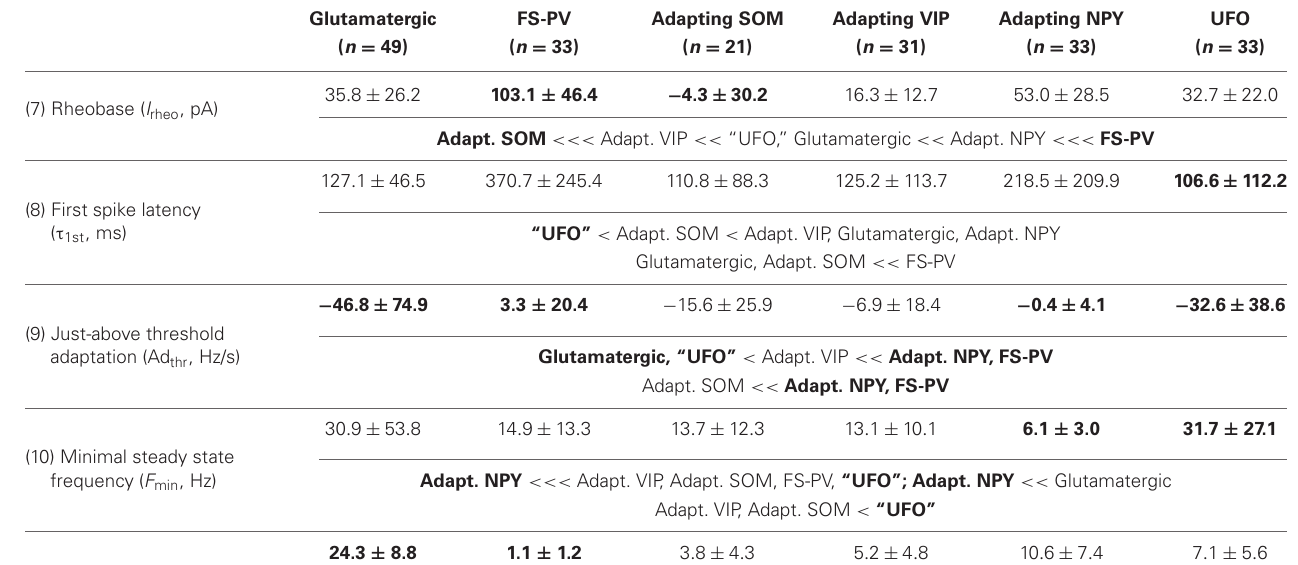
Table 2 | Above threshold features of different